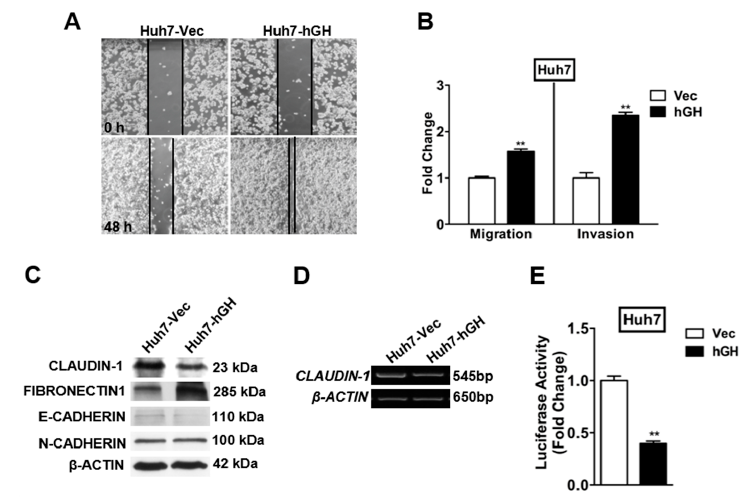
Figure 2. Forced expression of hGH promotes cell motility and an invasive phenotype in human HCC cells. ( A ) Cell motility was assessed by wound-healing assay under 100× magnification; ( B ) The effect of forced expression of hGH on Huh7 cell migration and invasion was determined by Transwell assay, ** p < 0.01; ( C ) Western blot analysis of the expression of epithelial and mesenchymal markers in Huh7-Vec/hGH cell lines; ( D ) The mRNA expression of CLAUDIN-1 in Huh7-Vec/hGH cell lines was assessed by RT-PCR; ( E ) CLAUDIN-1 promoter activity in Huh7-Vec/hGH cell lines was assessed by luciferase reporter assay, ** p <